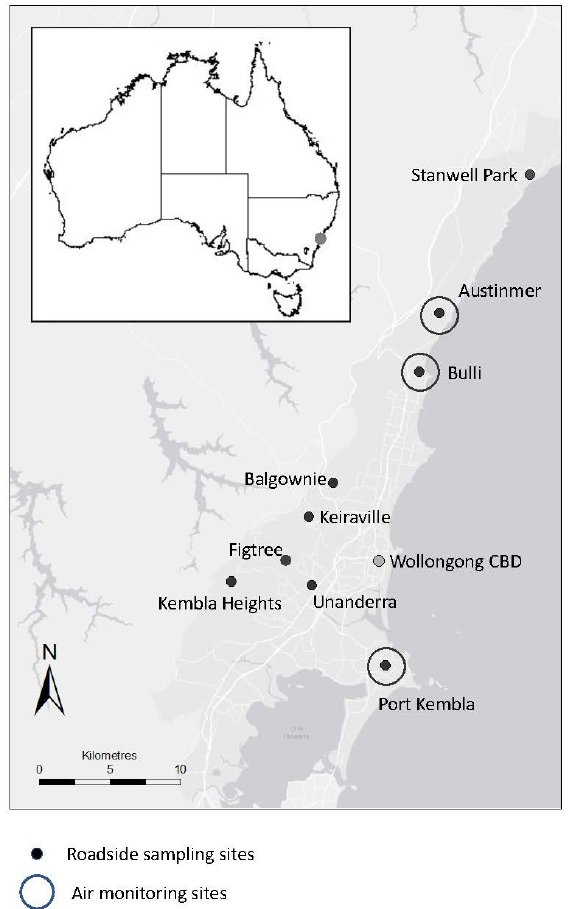
Figure 1. Map showing 9 roadside selection sites in Wollongong suburbs, NSW, Australia. “Low” urban sites on quiet roads are Stanwell Park, Austinmer, and Kembla Heights. "Medium" urban sites on suburban roads are Bulli, Figtree, and Balgownie. “High” urban sites on highways are Port Kembla, Unanderra, and Keiraville. Monitoring stations locations are also shown (Austinmer, Bulli, and Port Kembla). The fixed government monitor is near Wollongong CBD.